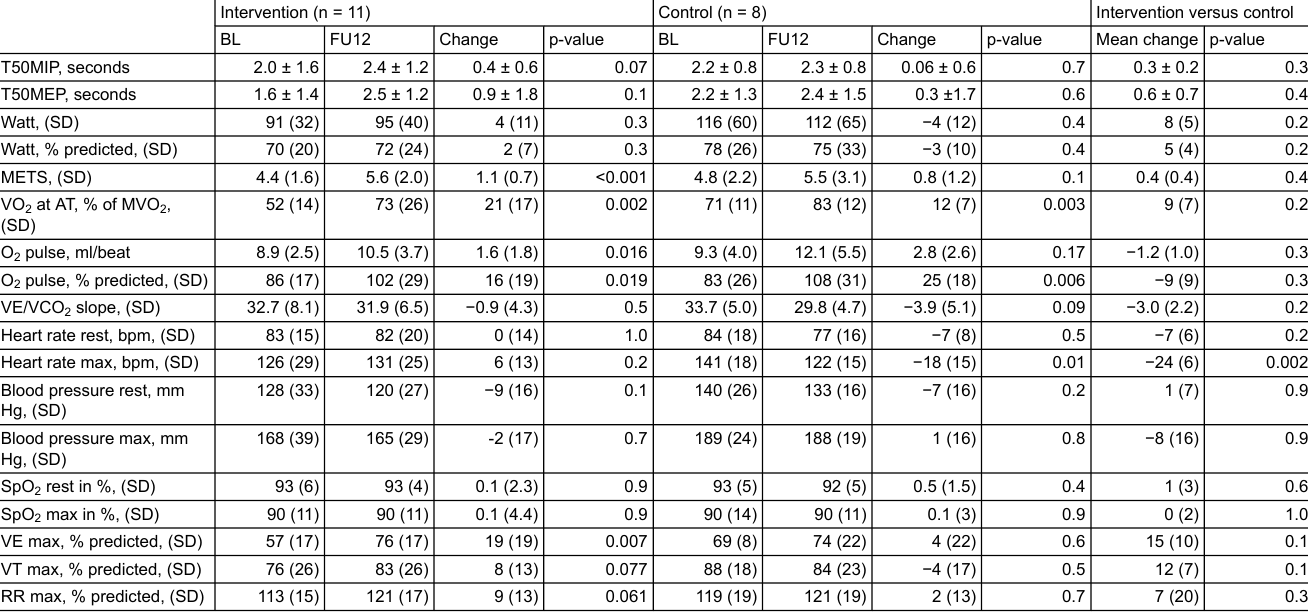
Table S2: Remaining indices of respiratory muscle strength and cardiopulmonary exercise testing. Intervention (n = 11) Control (n = 8) T50MIP, seconds